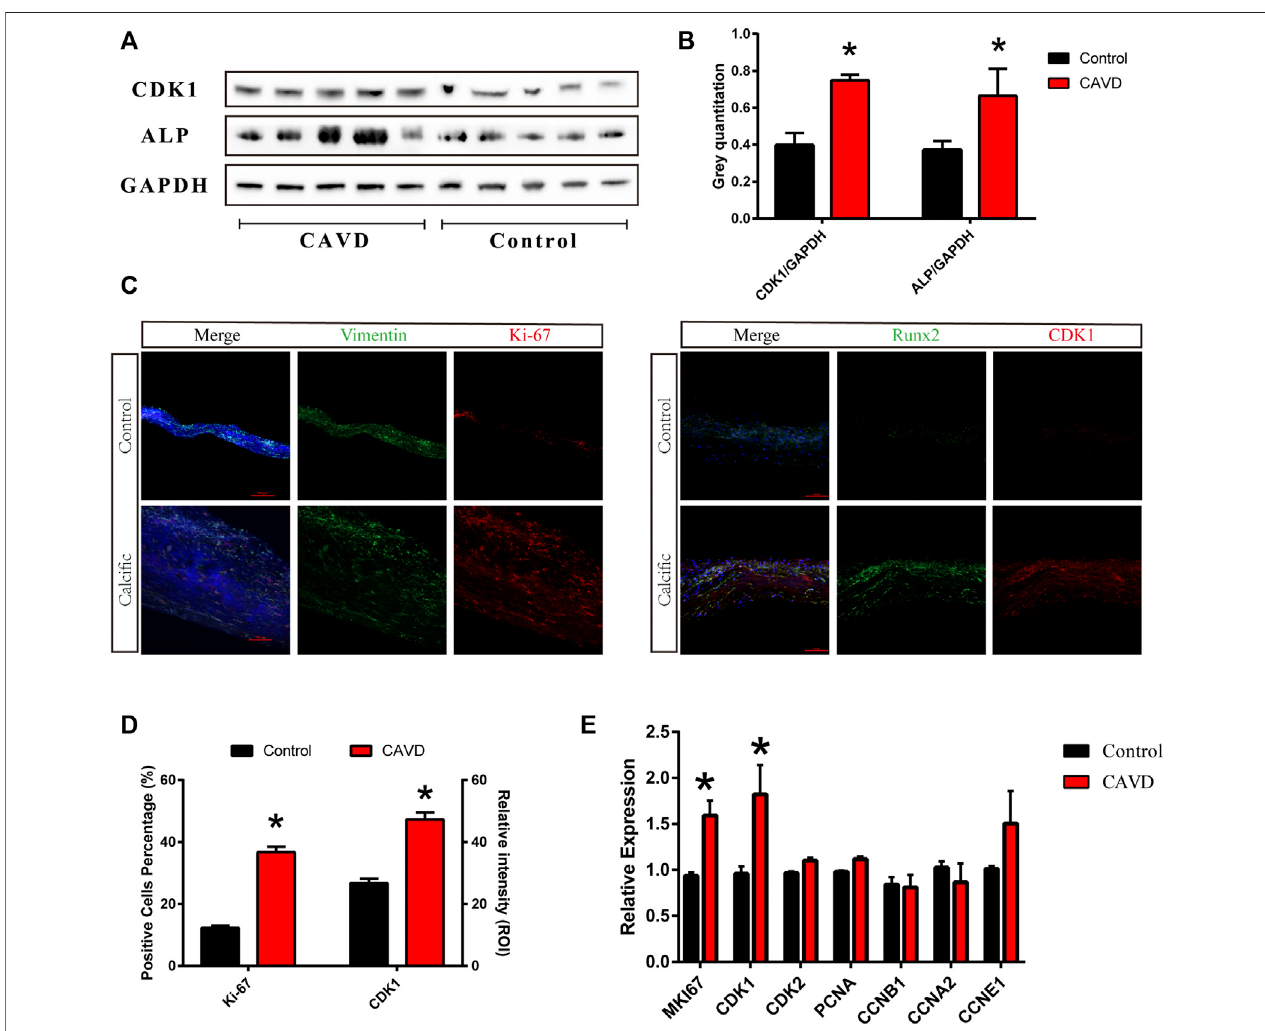
FIGURE1| Analysisofthe control and CAVD aortic valve samples ( n =5 and 5,respectively). (A) Westernblotting forCDK1 and ALPproteinson valvetissues. (B) Semi-quantitative analysis of protein expression. (C) Immuno fl uorescence staining of CDK1 and Ki-67 on valve tissues. (D) Semi-quantitative analysis of fl uorescence intensity. (E) PCR test for cell proliferation genes on valve tissues. (*) p < 0.05 indicates a signi fi cant difference.